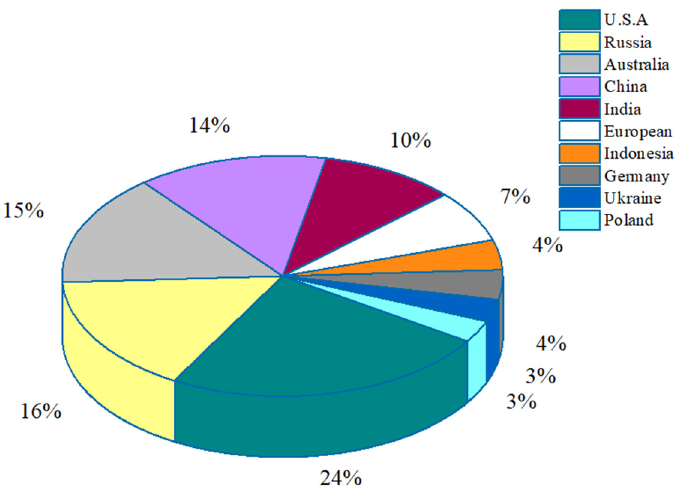
Figure 6. Proportion of the top 10 countries in global coal reserves in 2019.